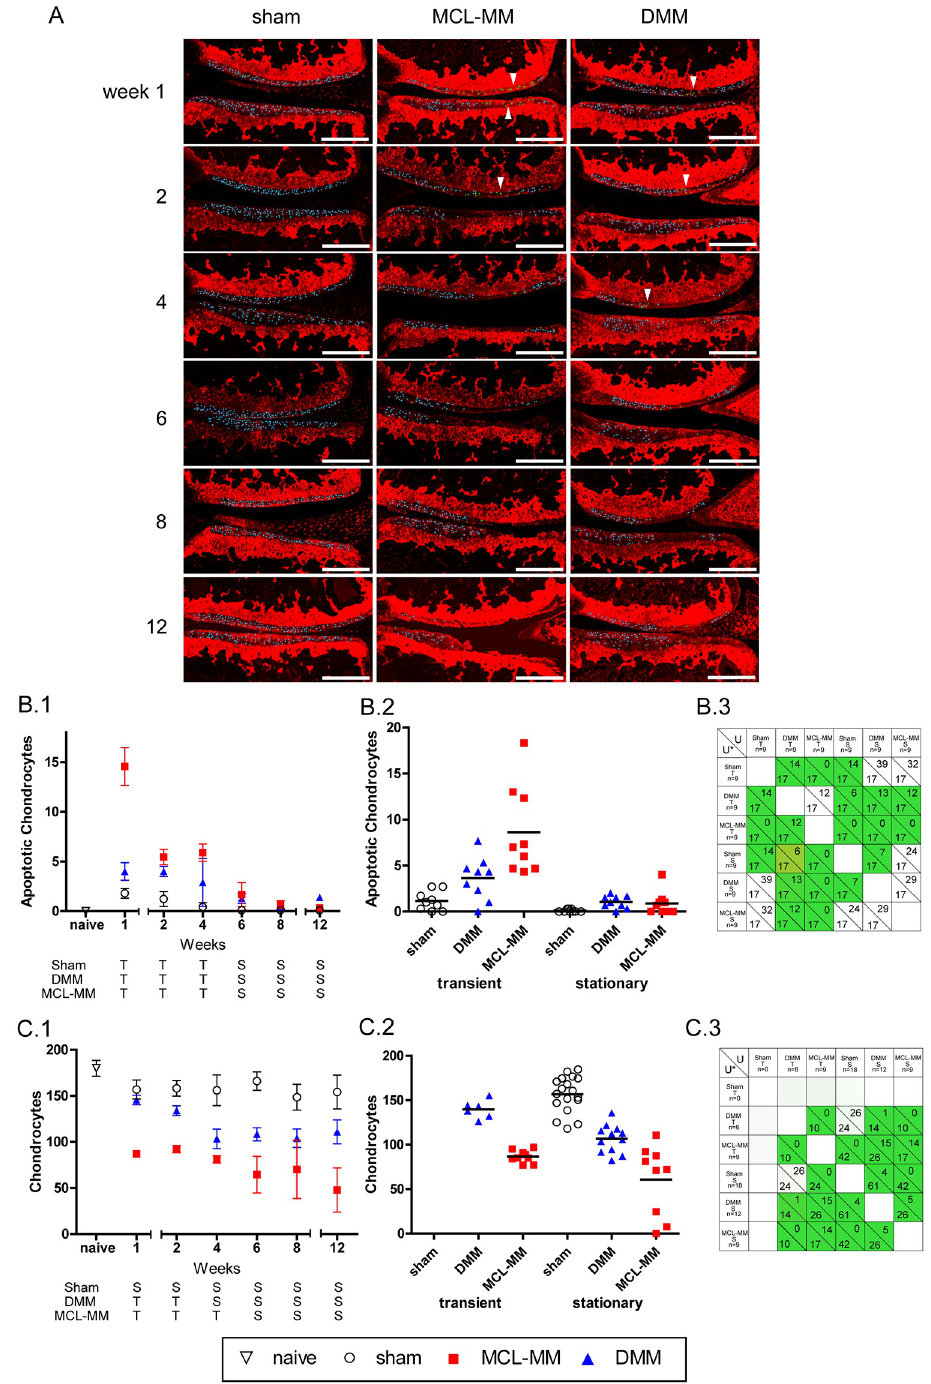
Fig 5. Automated quantification of chondrocyte numbers and apoptotic cells in the cartilage non-calcified zone of the tibial plateau and femoral condyle in different injury groups. A) Automatically detected and counted chondrocytes (blue) and apoptotic cells (green, arrow heads) in the medial aspect of the knee joint. Bar = 250 μ m. B.1-C.1) The time course (mean ± SEM) of the studied effects (average apoptotic chondrocyte population, average chondrocyte population) in the surgical OA models of interest (sham, DMM, MCL-MM). The trend analysis for the classification of time points into stationary (S) and transient (T) phases is given in S1 Methods. Apoptotic chondrocyte population samples in surgical OA models aggregated into phases: sham (T) (wks1-4), DMM (T) (wks1-4), MCL-MM (T) (wks 1–4), sham (S) (wks 6–12), DMM (S) (wks 6–12), MCL-MM (S) (wks 6–12). C.2) Chondrocyte population